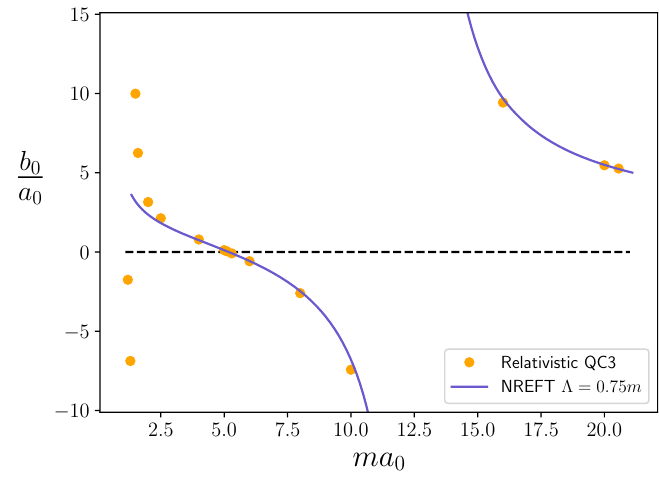
Figure 8 . Ratio of particle-dimer scattering length, b 0 , to the fundamental scattering length, a 0 , as a function of ma 0 . Orange points give the results obtained from the analysis described in this subsection applied to the output of the three-particle quantization condition (QC3). The solid (blue) line is the result from (in(cid:12)nite-volume) NREFT, discussed in more detail in appendix B. The rapid variation of points on the left-side of the plot correspond to a narrow pole in the relation between b 0 and a 0 that only arises in the relativistic